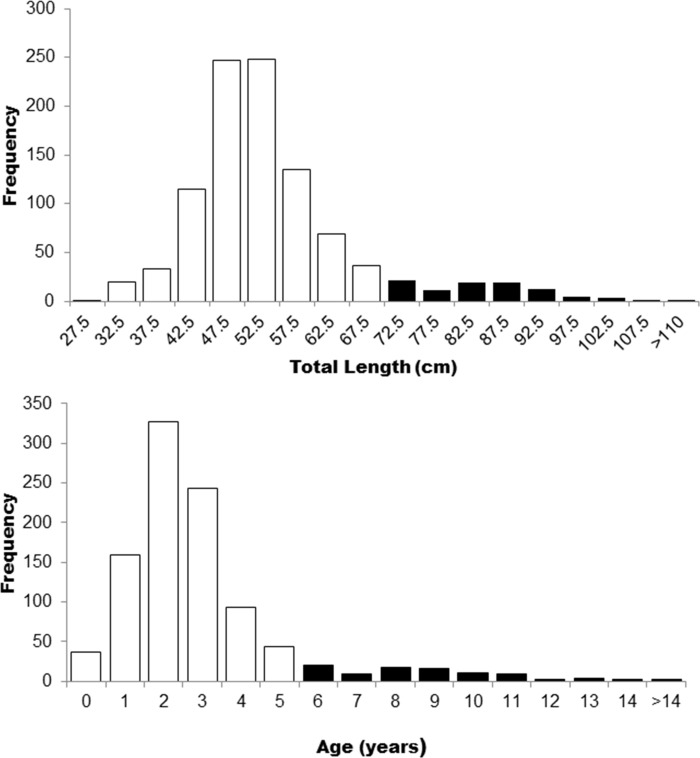
Total length (a) and age (b) frequency distributions of juvenile and adult individuals of Carcharhinus porosus from Northern Brazil. White columns correspond to juveniles and black columns to adults.